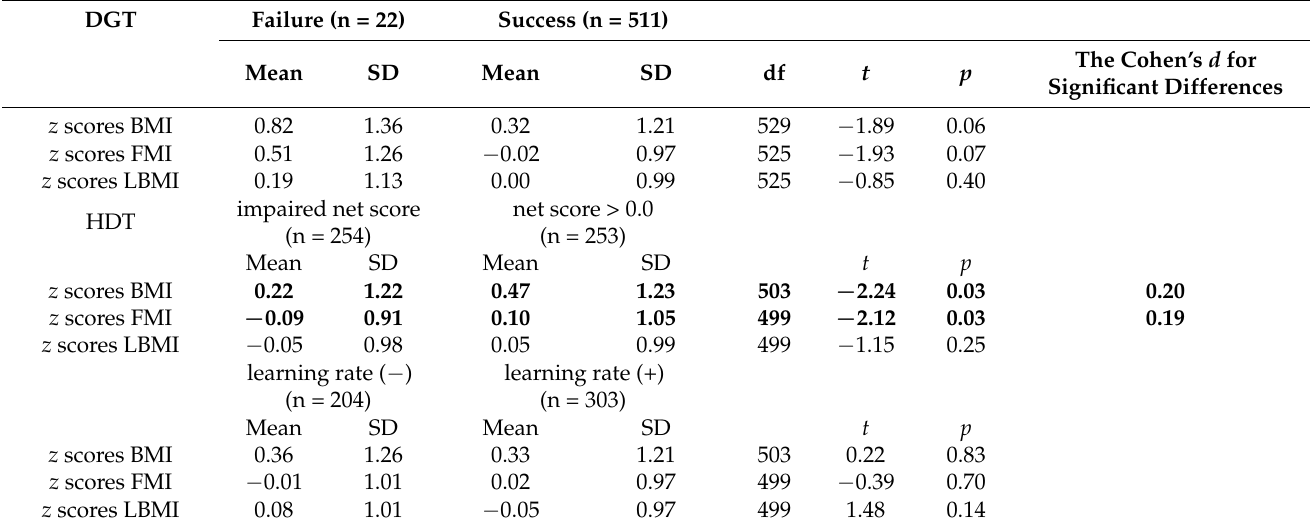
Table 1. The differences in z scores BMI, FMI, and LBMI between children divided according to results of the delay of gratification task and the Hungry Donkey task. The t -test